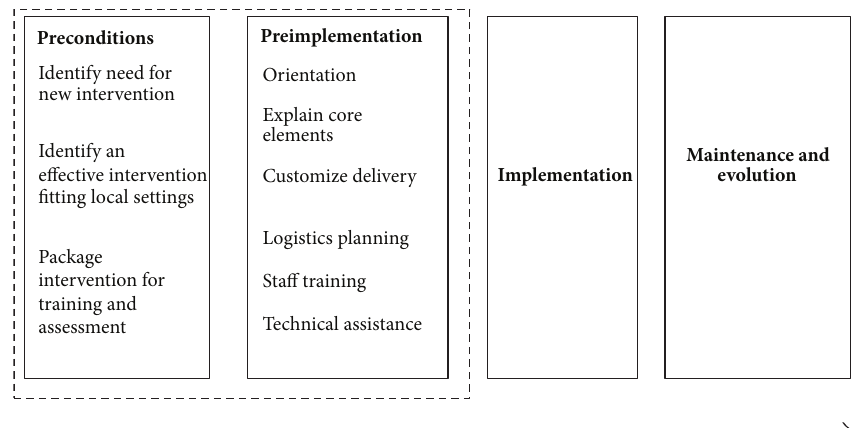
Figure 1: REP framework as used to plan for diabetes self-management